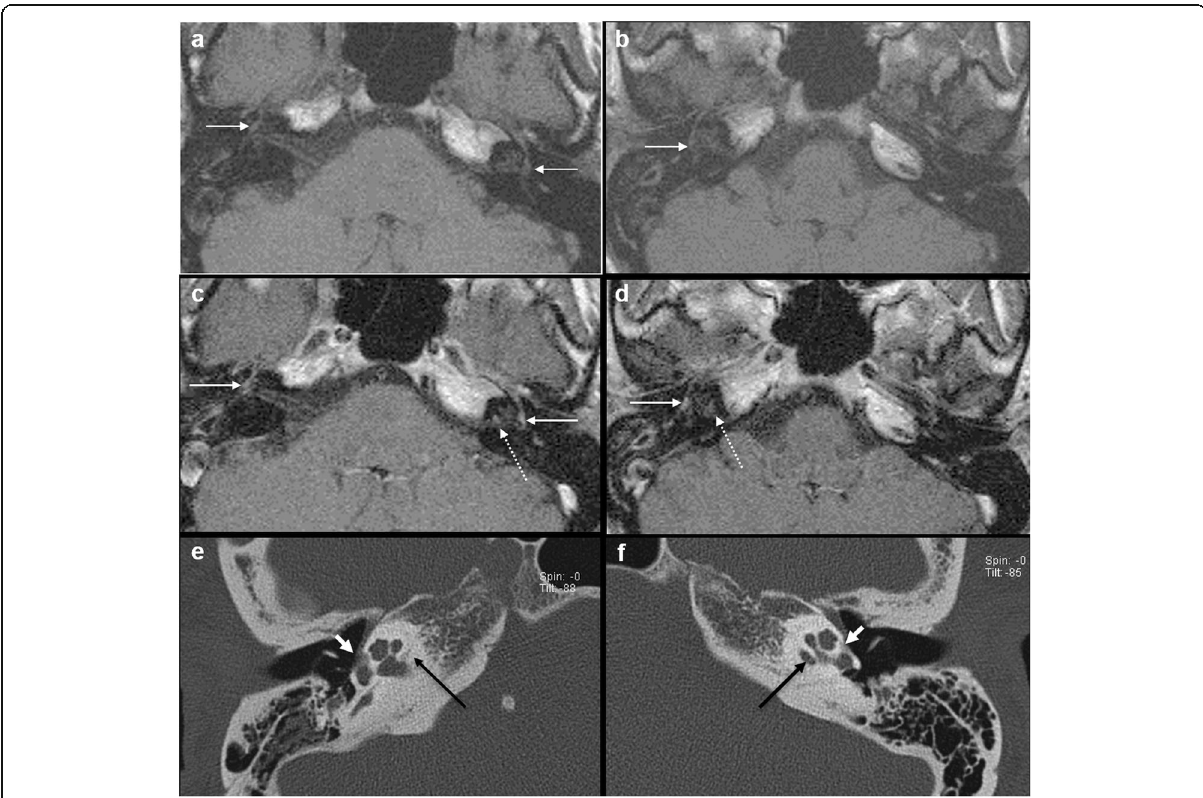
Fig. 1 A 43-year-old female patient with right-sided SNHL (case 1). Axial T1W MR images ( a , b ) show subtle intermediate T1 signal in bilateral FA regions (arrows). Contrast-enhanced axial T1W images ( c , d ) show moderate post-contrast enhancement in bilateral FA regions (arrows) and mild post-contrast enhancement in bilateral pericochlear regions (dashed arrows). Subsequent axial HRCT images ( e , f ) confirm bilateral fenestral otosclerotic plaques (short white arrow) and pericochlear plaques (black long